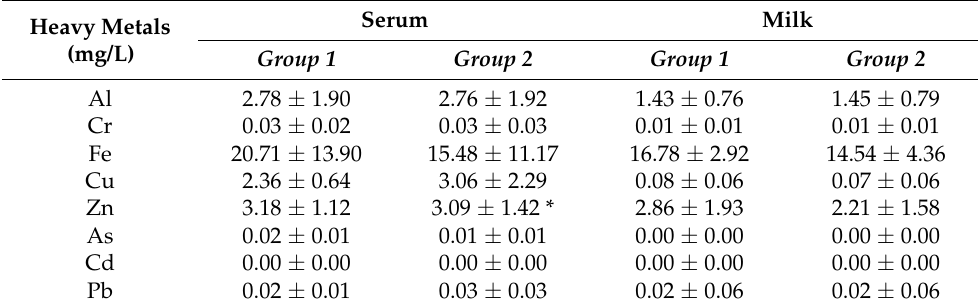
Significances: * vs. milk ( p > 0.05).